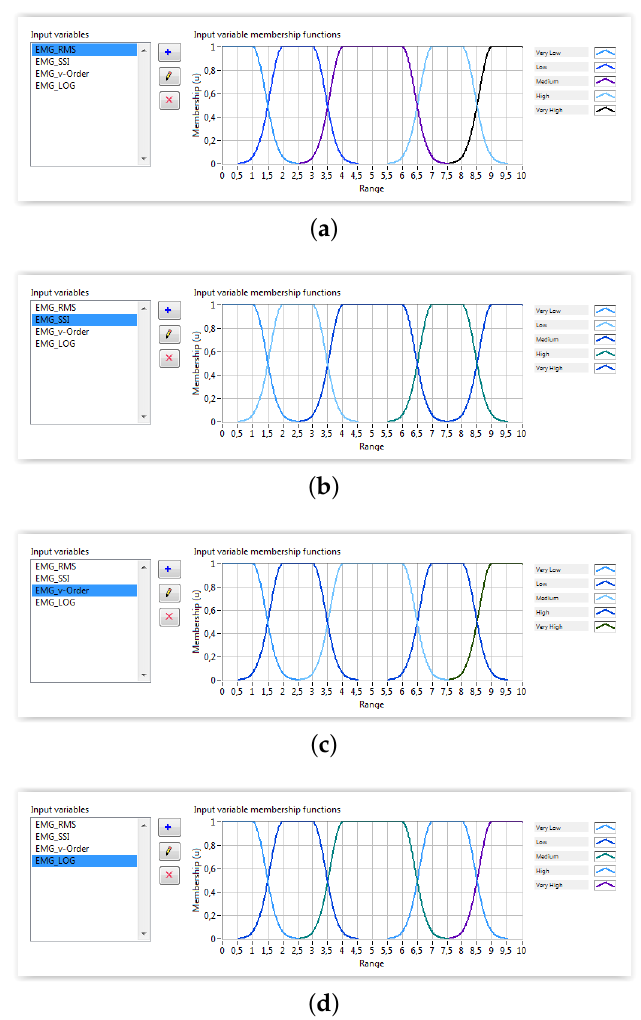
Figure 7. First block inputs fuzzy membership functions: ( a ) EMG-RMS; ( b ) EMG-SSI; ( c ) EMG-v-order;